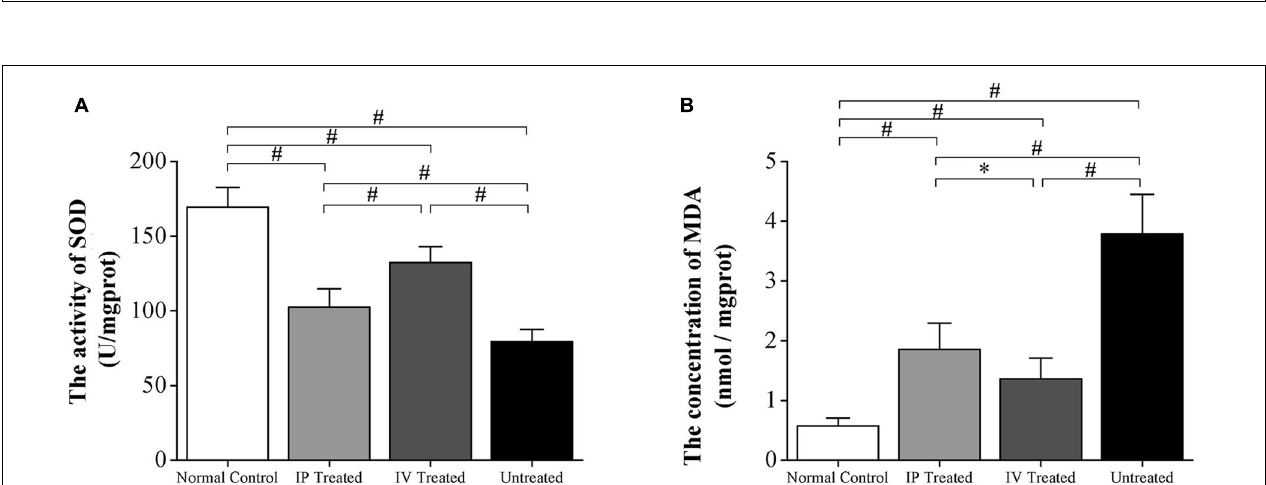
FIGURE 4 | Hydrogen rich saline induced effects on the oxygen stress markers of MNU administered rats. (A) The SOD level of the untreated group was significantly lower than the IV and IP treated group ( P < 0.01). Particularly, the SOD level of IV treated group was substantially higher than the IV and IP treated group ( P < 0.01). (B) The MDA level of the untreated group increased drastically than the normal controls ( P < 0.01). The MDA level of both IV and IP treated groups also increased significantly than the normal controls ( P < 0.01). However, both of them were significantly lower than the untreated group ( P < 0.01). The MDA level of the IV treated group was significantly lower than the IP treated group ( P < 0.01). (All the values were presented as mean ± SD; ∗ P < 0.05, # P < 0.01 for differences compared between the animal